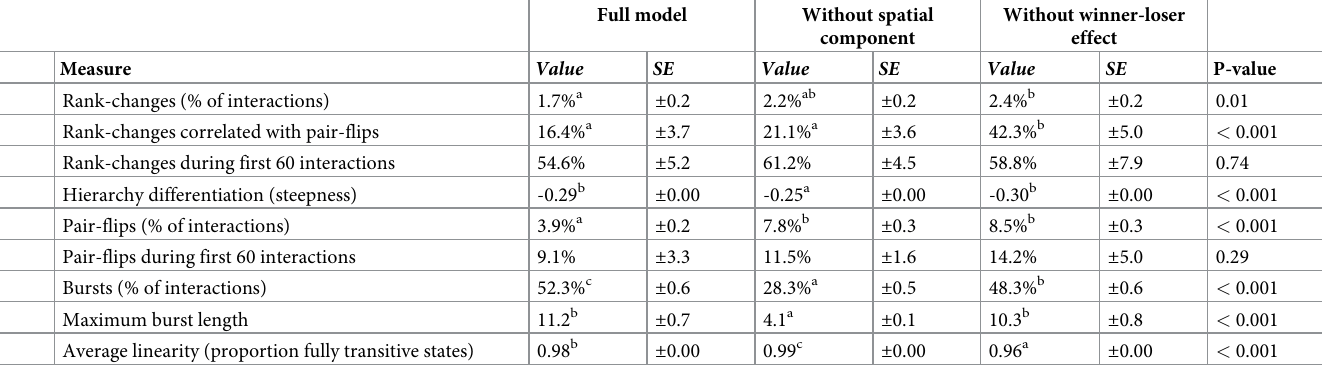
Table 2. Quantitative measures of dominance behaviour and network for the three versions of the model, namely the full model, the model without the spatial com- ponent, and without the winner-loser